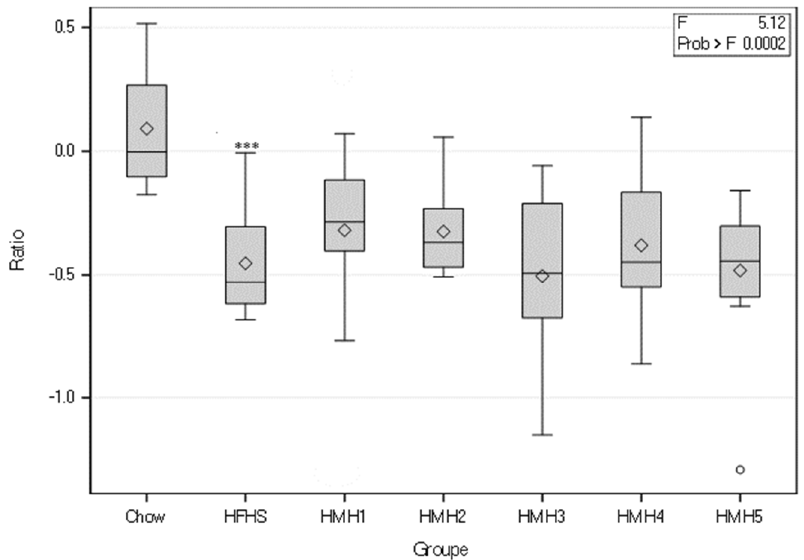
Figure 8. Differential abundance Bacteroidetes/Firmicutes ratio calculated for each group. *** p < 0.05 Chow vs.